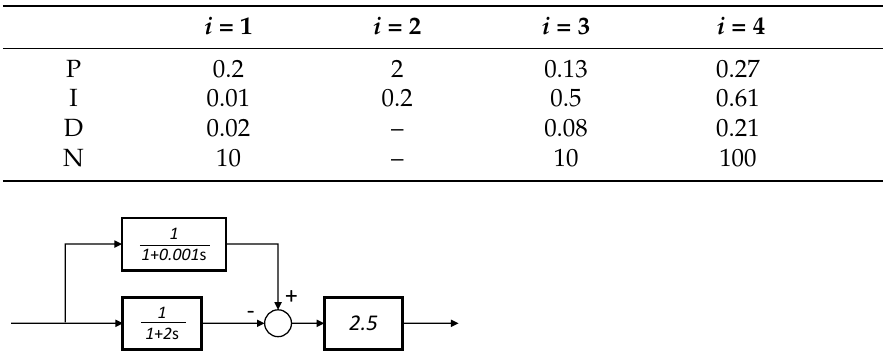
Table 1. Tuning parameters of simulated controllers R i —Matlab PID implementation.